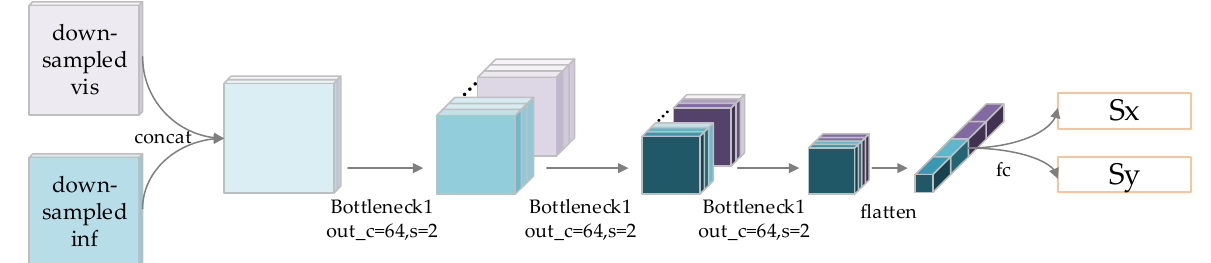
Figure 5. Process of offset estimation module.